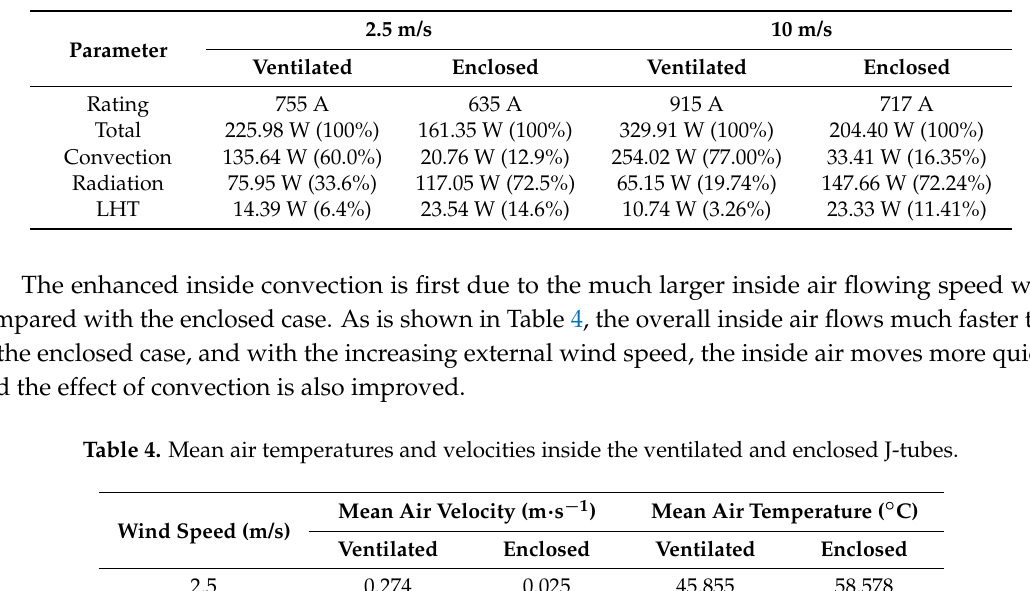
Table 3. Heat transfer modes for the heat generated in the cable in the air section.